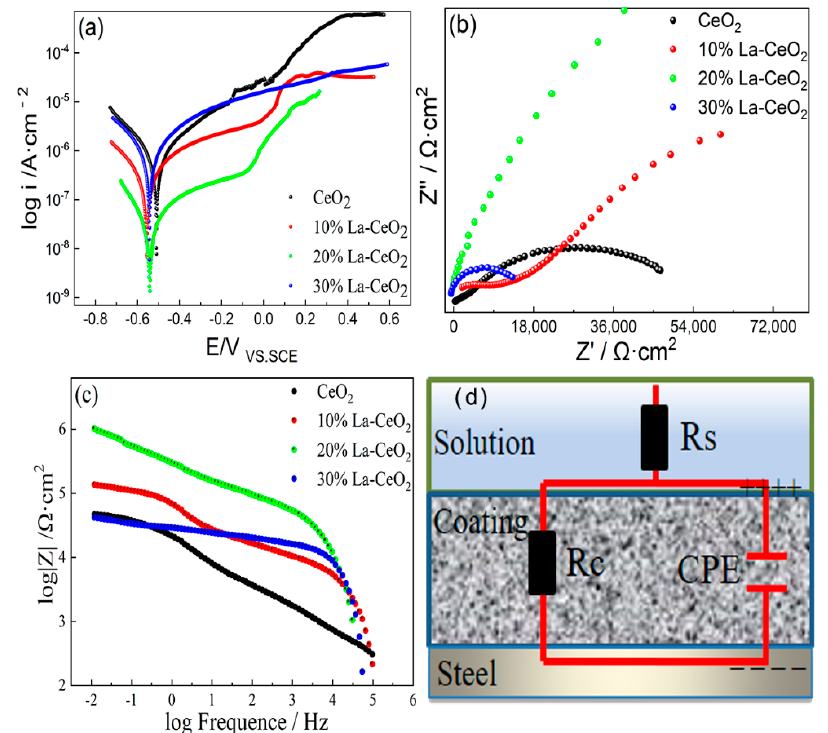
Figure 8. Electrochemical analysis of La-doped CeO 2 coatings after UV irradiation for 12 h. ( a ) Polarization curves, ( b ) Nyquist plots, ( c ) Bode plots and ( d ) equivalent circuit. Table 2. Electrochemical data of La-doped CeO 2 coating after UV irradiation for 12 h.